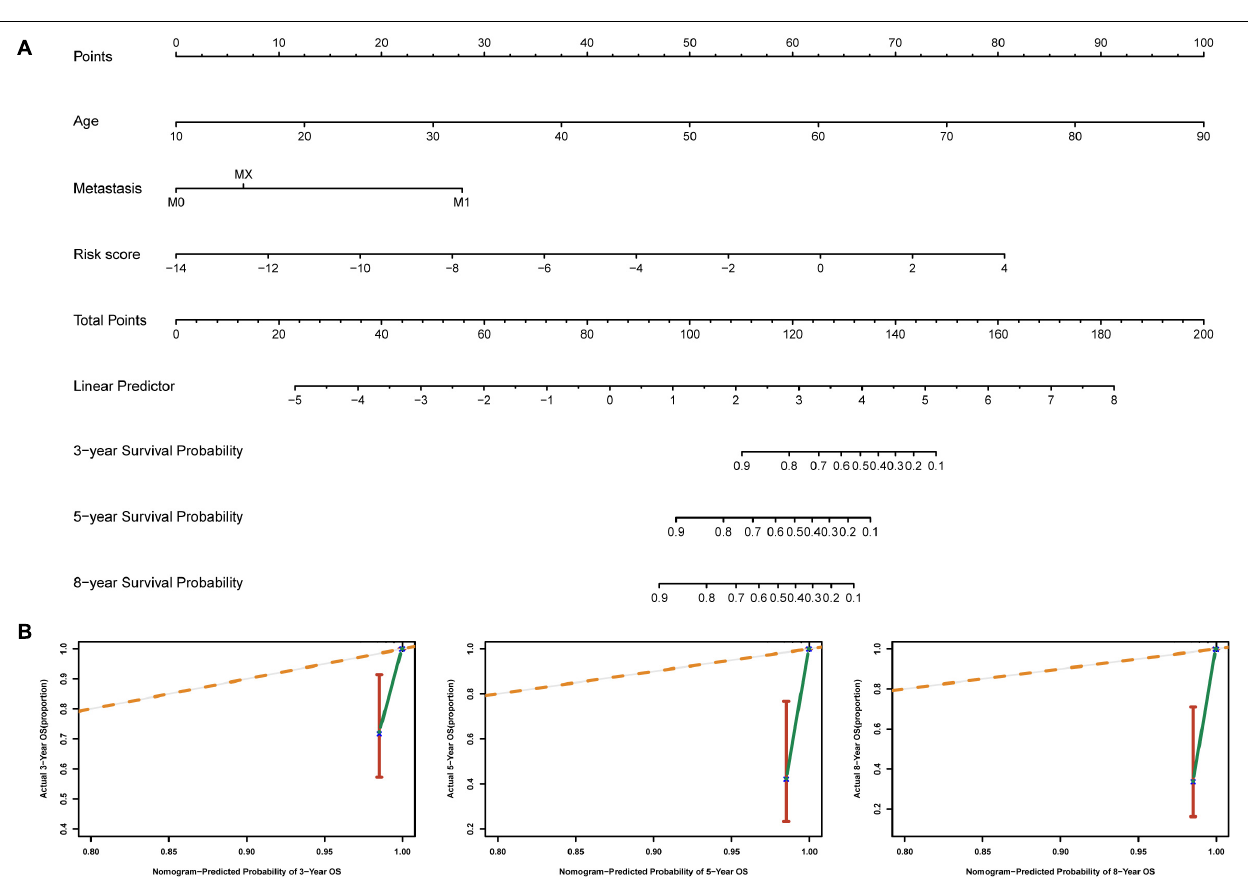
transplant rejection, and the IL-6/JAK/STAT3 pathway, and the low-risk group may be associated with components of the blood coagulation system, late responses to estrogen and the apical junction complex ( Supplementary Table S4